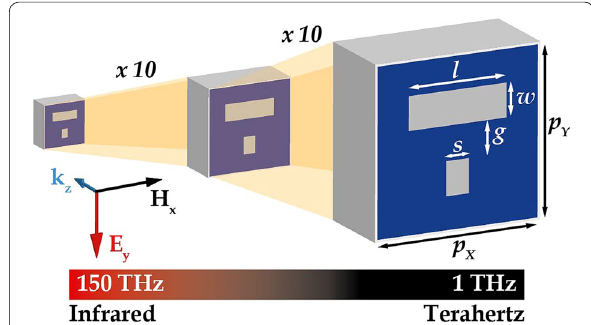
Fig. 1 Schematic illustration of the asymmetric dipole bars with the dimensions enlarged proportionally from NIR to THz regime. The electric field and magnetic field are polarized along the y - and x -axis respectively, and k z is the propagation direction of the incident plane wave source